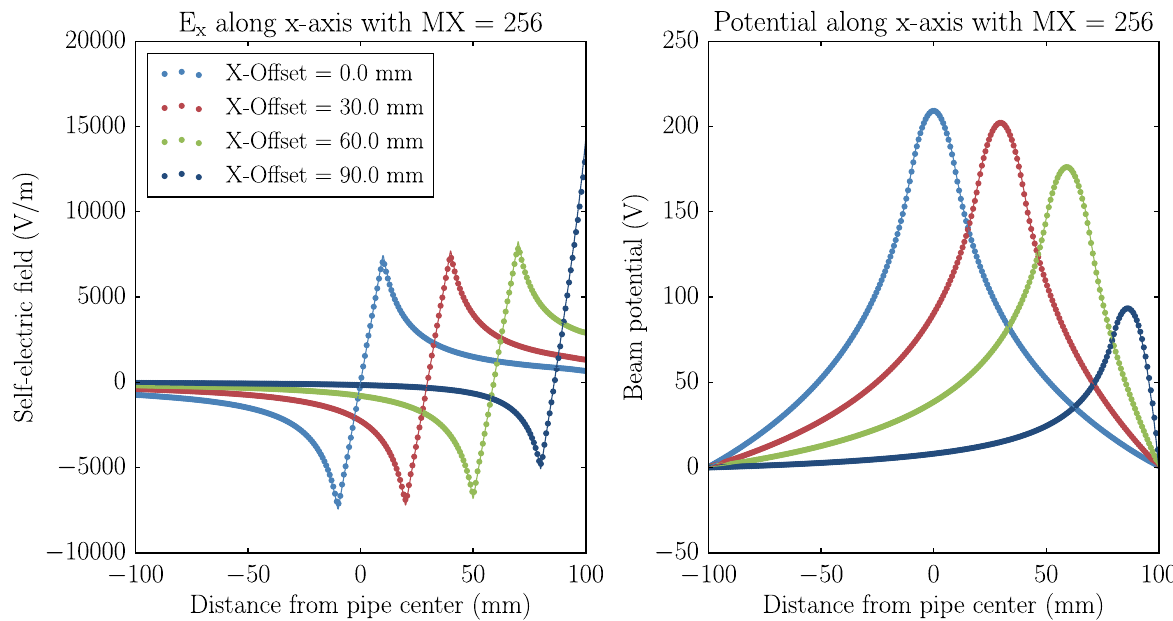
FIG. 7. ϕ and E along the x-axis for different offsets ξ . Dots are values calculated by OPAL, while solid lines are the analytical x solution. Excellent agreement can be seen with 0 . 01 < χ 2